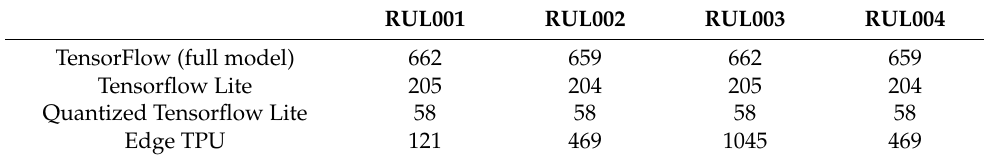
Table 2. File sizes of the full TensorFlow, TensorflowLite, and quantized TensorflowLite models in kB.